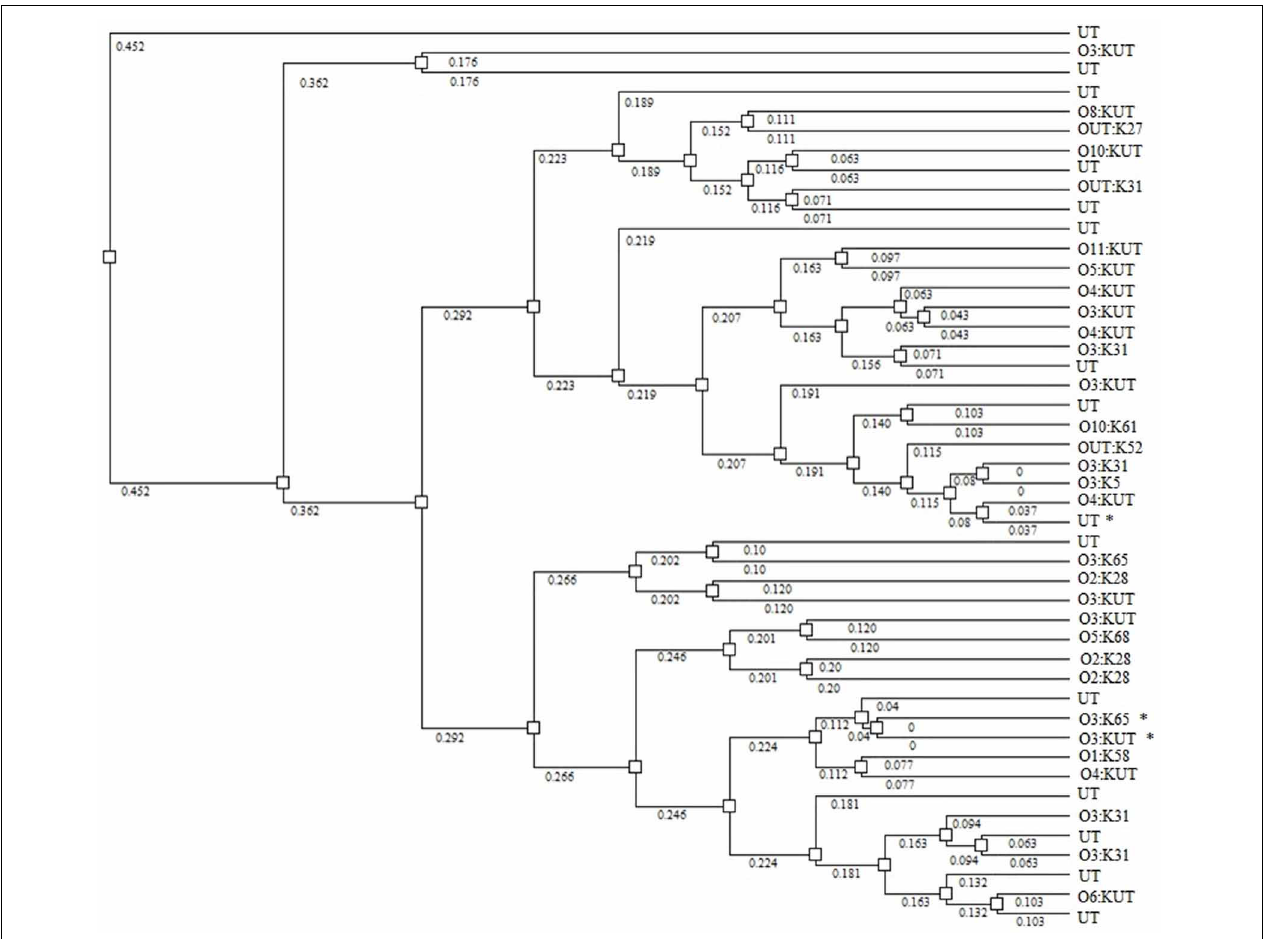
FIGURE 3 | Dendrogram showing relatedness of V. parahaemolyticus strains by rep-PCR. Asterisks identify strains that are GS-PCR-positive. Numbers on branches indicate degree of divergence between isolates.